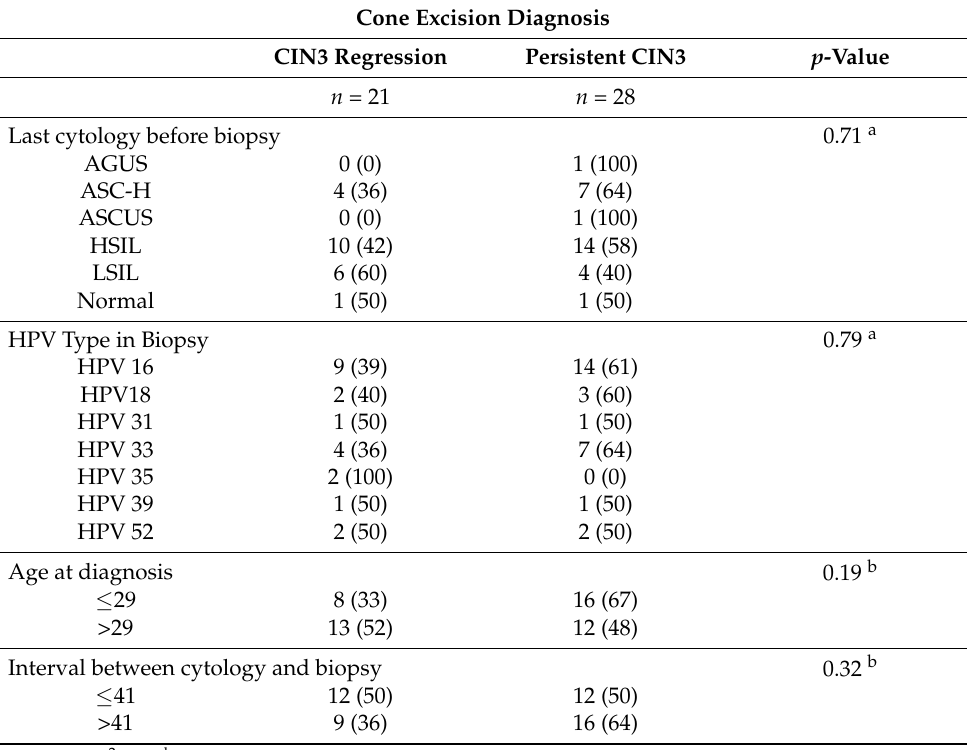
Table 1. Distribution of clinicopathological characteristics for all CIN patients included in this study. The number of cases in each group is given followed by percentage for each row in